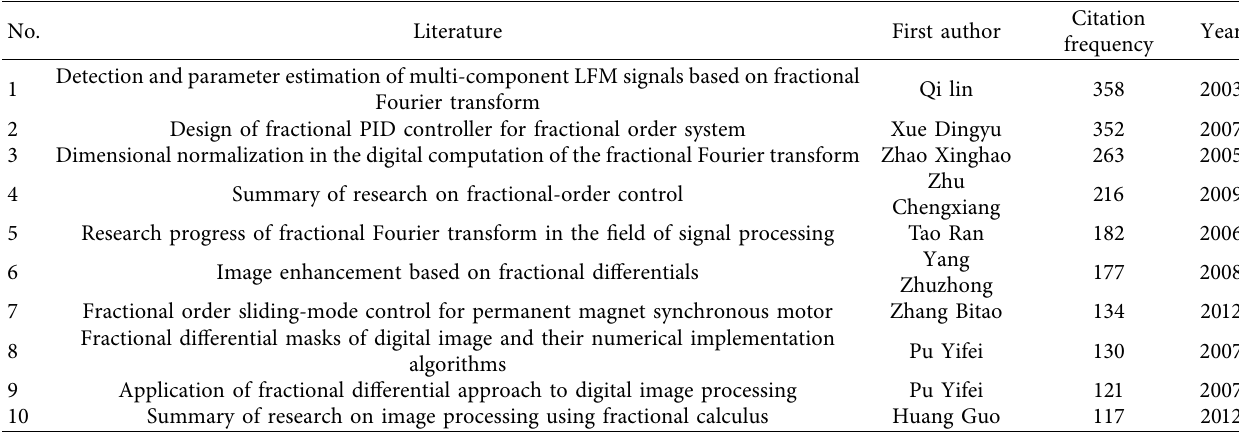
Table 2: Statistics of top 10 important literatures cited in